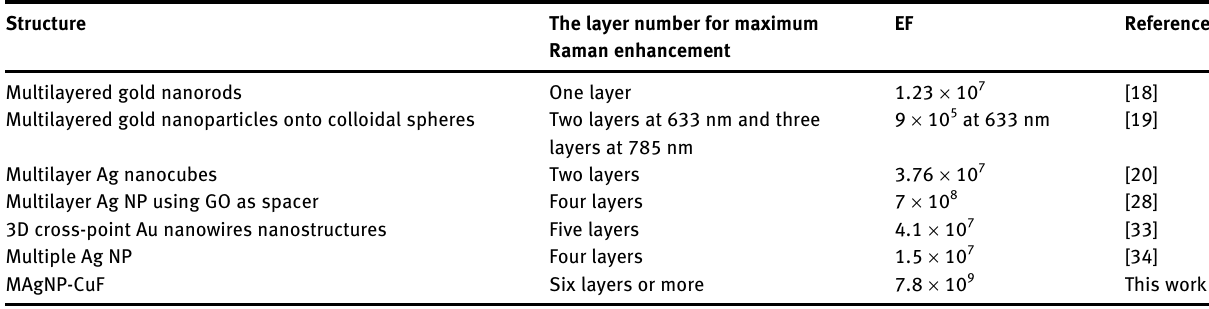
Table  : A comparison between the reported multilayered nanostructures and the MAgNP-CuF substrate. Structure Multilayered gold nanorods Multilayered gold nanoparticles onto colloidal spheres Multilayer Ag nanocubes Multilayer Ag NP using GO as